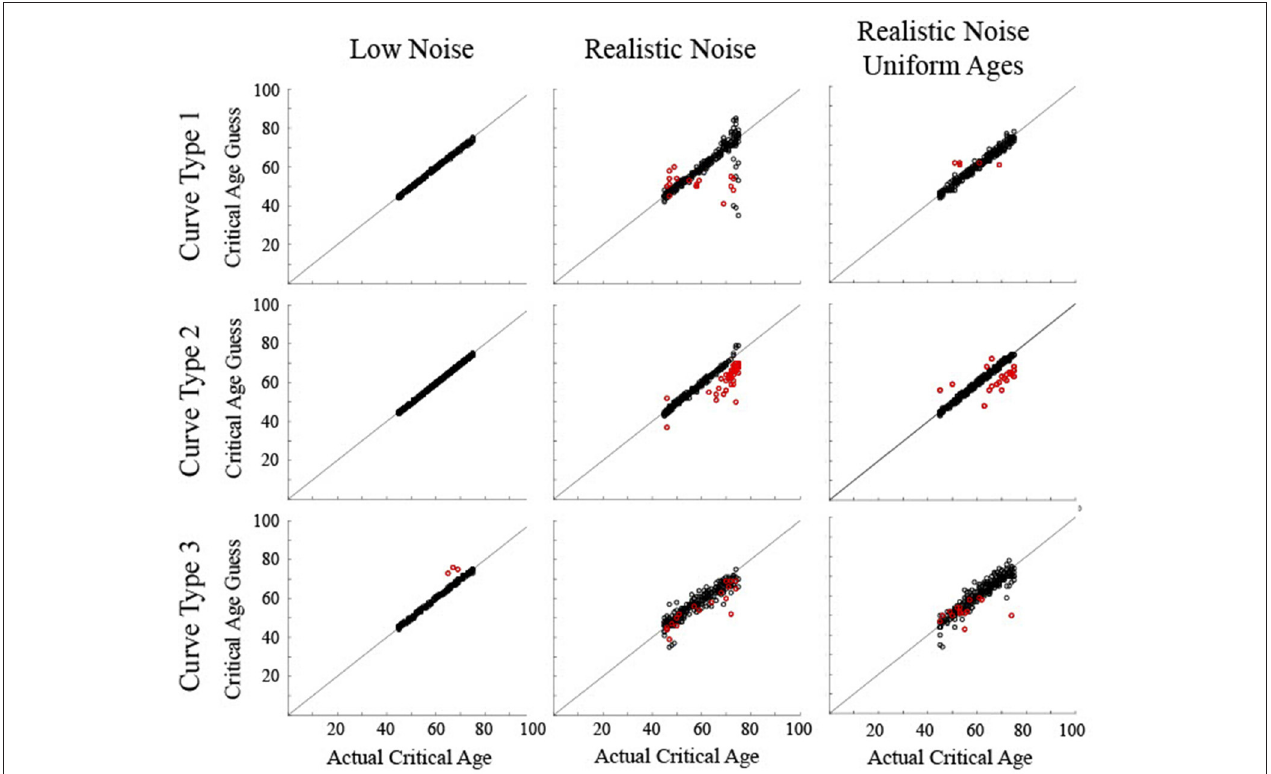
FIGURE 8 | Scatter plots show the critical age guesses for the simulated data following a classification procedure to determine which particular derivative zero point to use. Black circles show correct classification of curve type. Red circles show incorrect classification of curve type. Points along the diagonal line indicate a match between the calculated critical age and the actual critical age of the stimulated